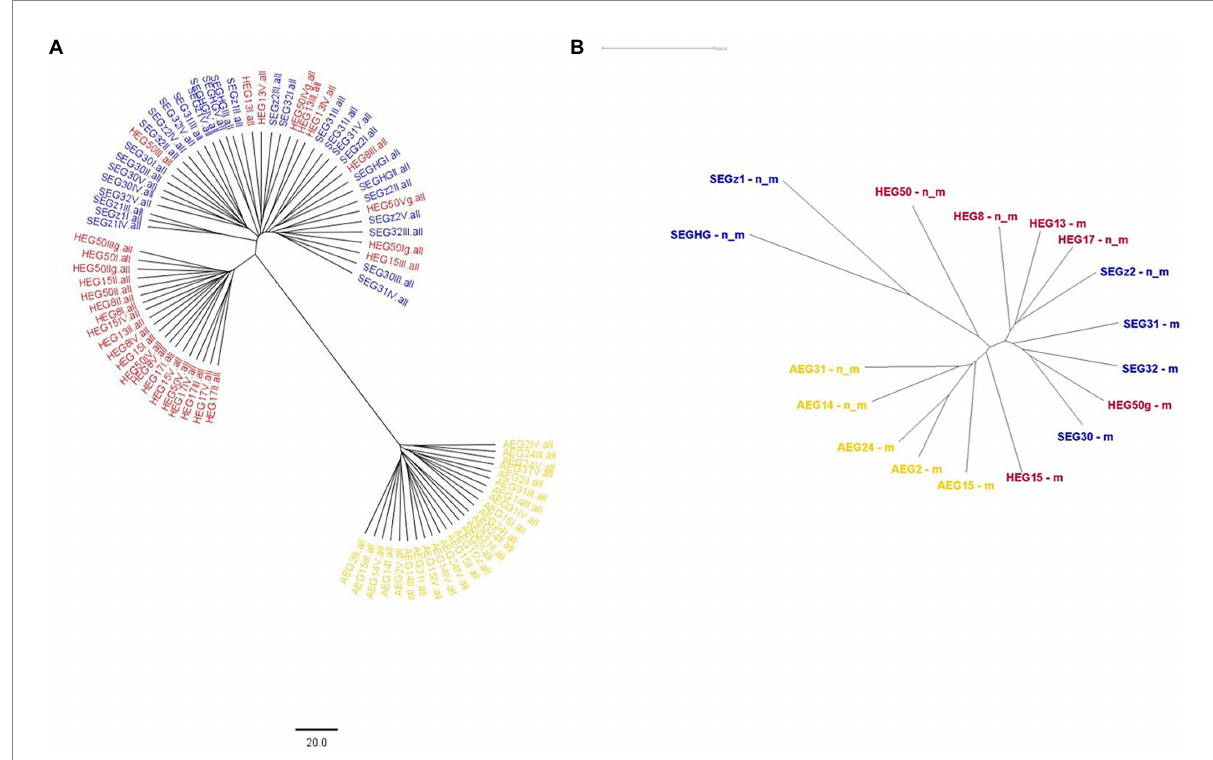
FIGURE 6 Neighbor Joining tree for the individuals and populations of Trifolium pratense across the different Biodiversity Exploratories (yellow: Schorfheide- Chorin; red: Hainich-Dün; blue: Swabian Alb). (A) The GBS analysis. (B) The mRNA-GBS analysis (n_m, not mown, m,